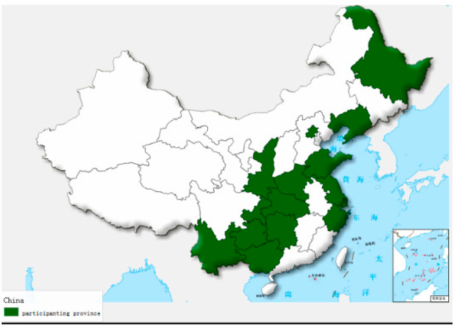
Figure A1. Sampling provinces of China Health Nutrition Survey (CHNS) in